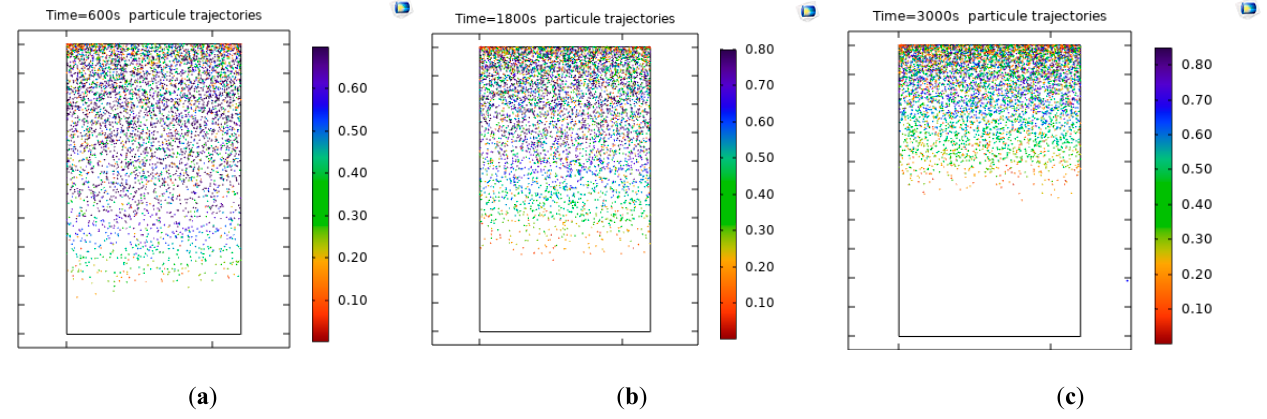
Figure 9. Two-dimensional (2D) distribution and velocity of particles within the reactor at three different times: ( a ) 600 s, ( b ) 1800 s and ( c ) 3000 s.